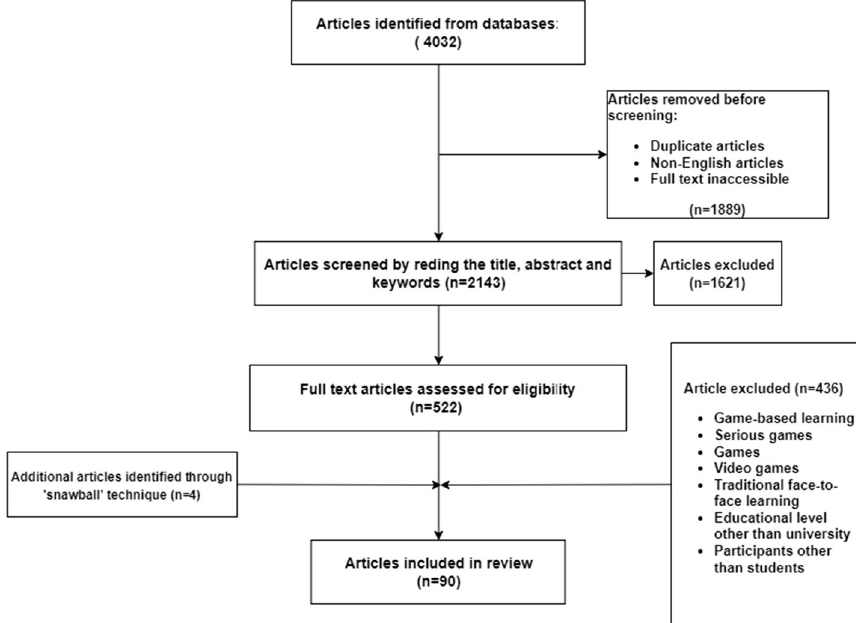
Fig. 1 Flow diagram of the articles selection